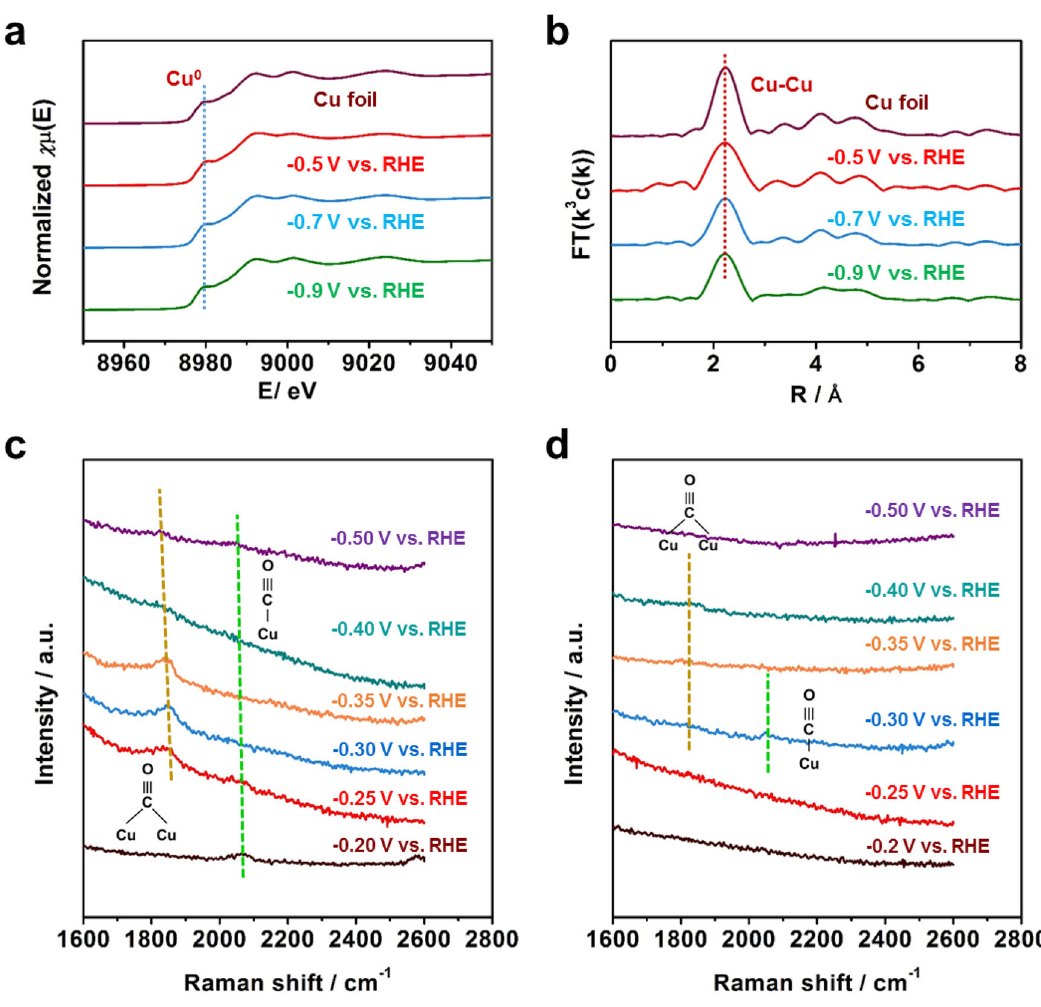
Fig. 4 | The operando and in situ SERS for R-8-Cu-12 and R-Cu-np. a The oper- ando XANES spectra at the Cu K-edge for R-8-Cu-12 at different potentials during CO 2 electrolysis. b The corresponding Fourier transforms FT( k 3 w( k ))for R-8-Cu-12